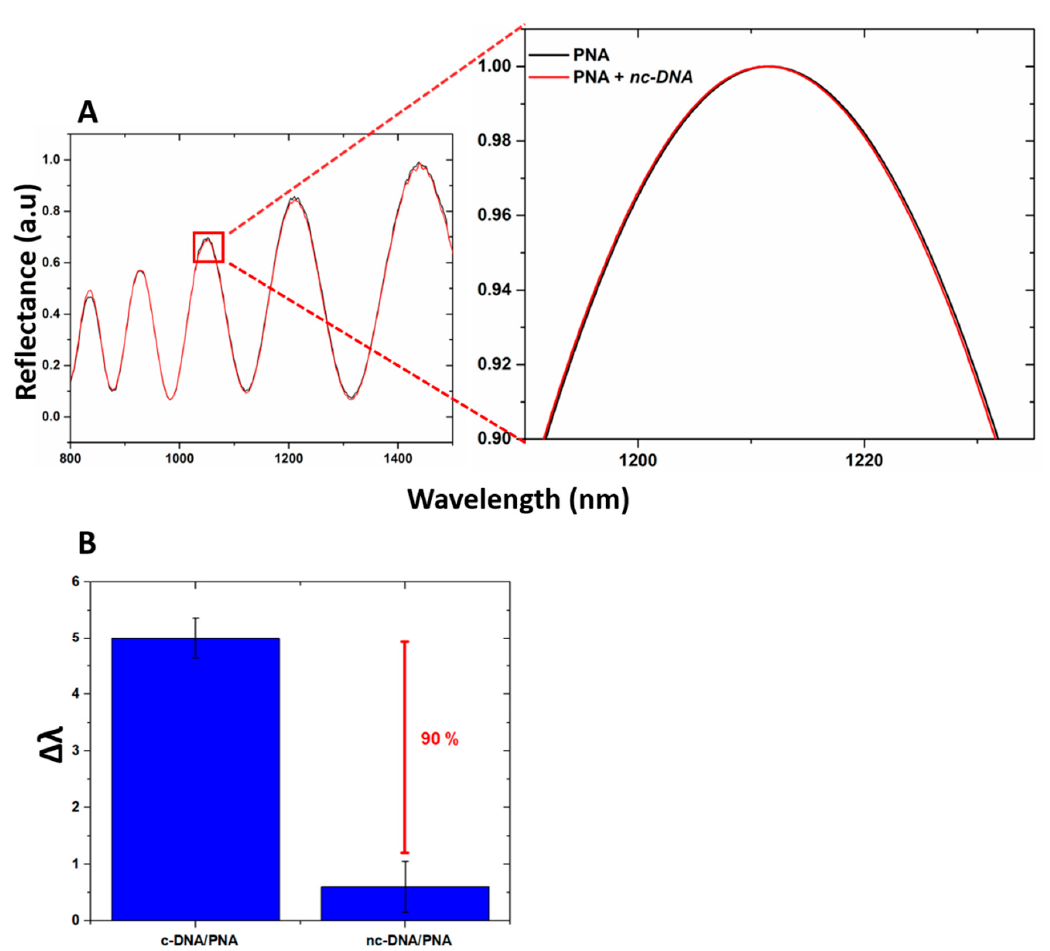
Figure 7. ( A ) reflectivity spectra of PNA-GO / PSi device after the DNA polyT incubation (nc-DNA); ( B ) comparison between reflectance shift values ( ∆ λ ) of the PNA-GO / PSi device after interaction with 100 µ M c-DNA and 100 µ M nc-DNA .